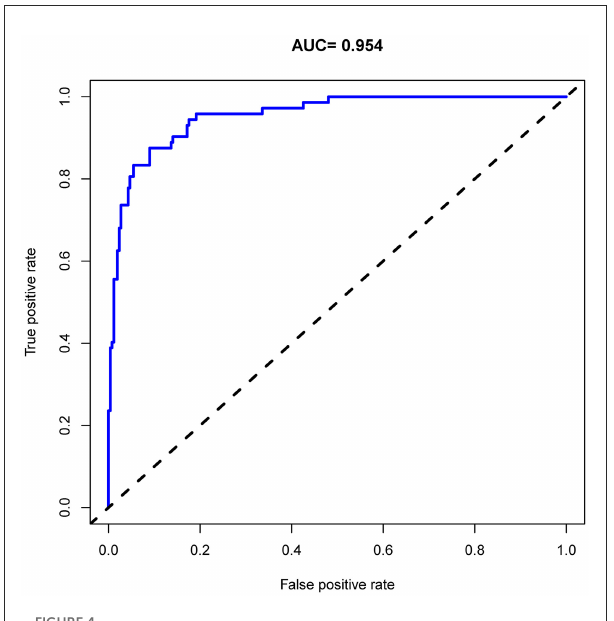
FIGURE4 Receiver operating characteristic (ROC) curve analysis of the nomogram for predicting risk of death during hospitalization in patients with AD.